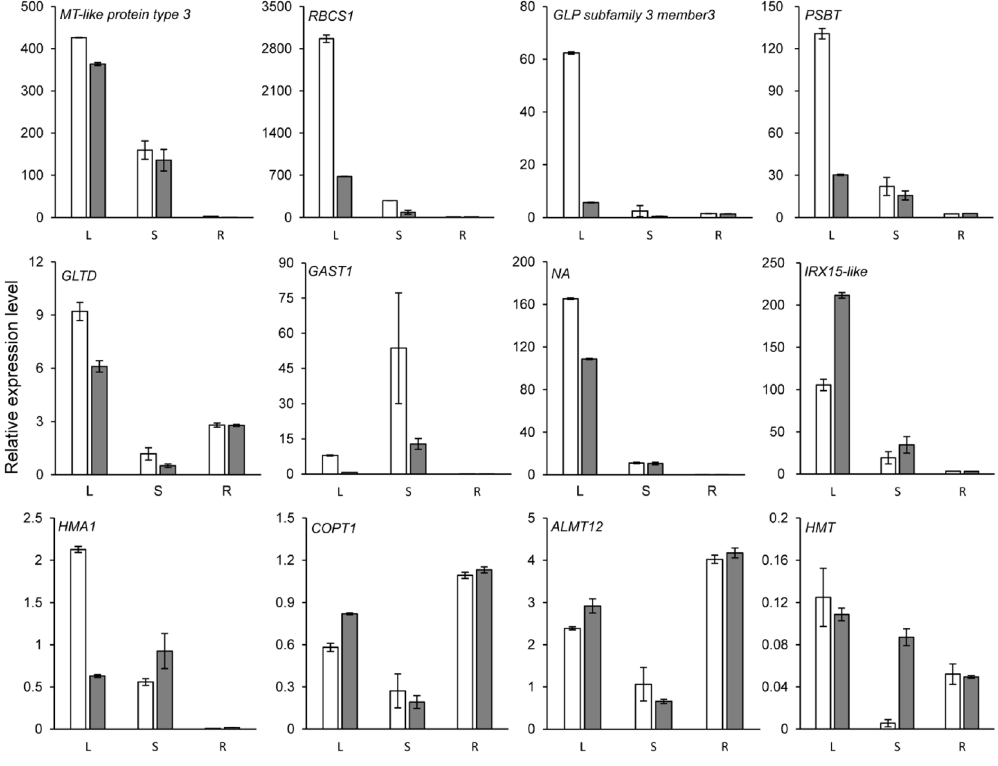
Fig 5. Gene expression patterns in leaf (L), stem (S), and root (R) samples of P . americana with (grey column) and without (white column) Cd